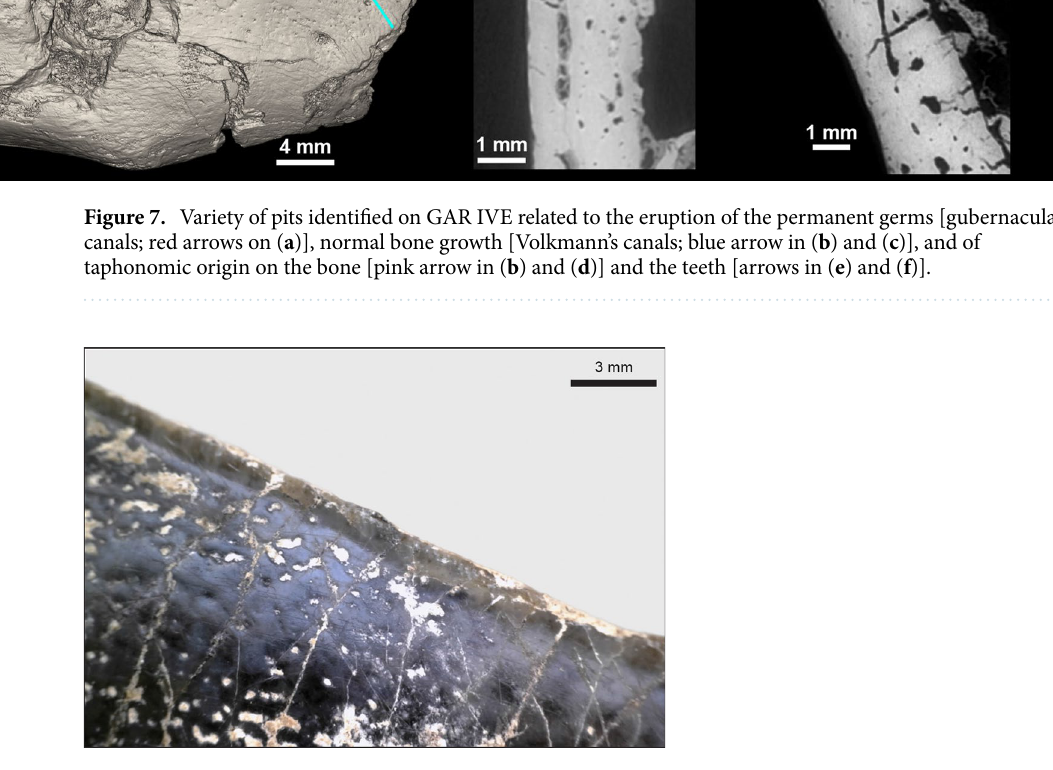
Figure 8. Close-up on the enamel surface of a Hippopotamus canine from Garba IVE, showing